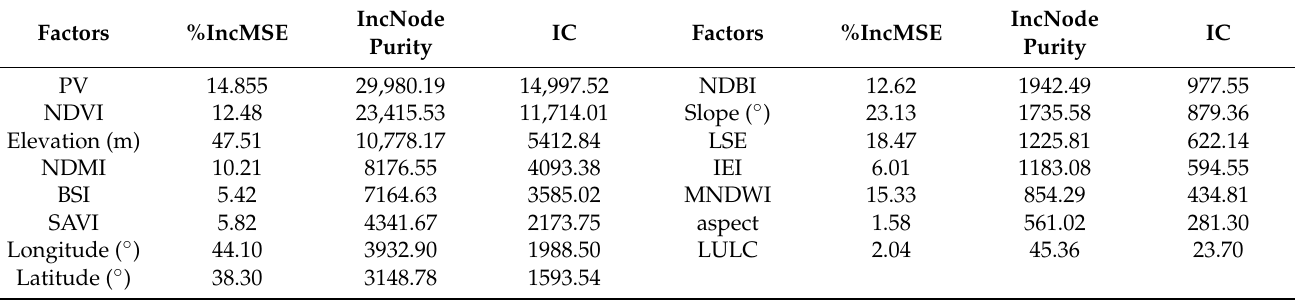
Table 2. Variable importance of each factor in the RF regression for Image A1 (%IncMSE denotes the percentage increase in the mean squared error (MSE), IncNode Purity represents the increase in the tree node purity, and IC is integrated contribution index by calculating the average value between %IncMSE and IncNode